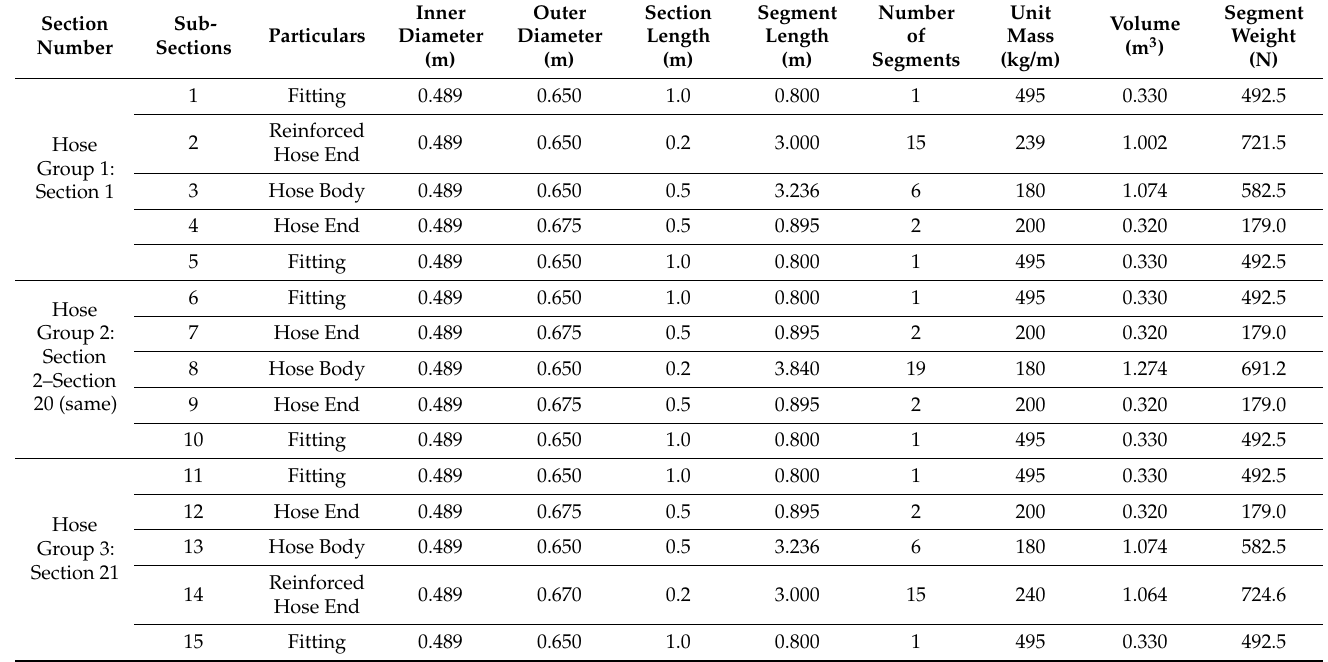
Table 3. Parameters for the submarine hose for Lazy-S configuration with section details arrange- ment.